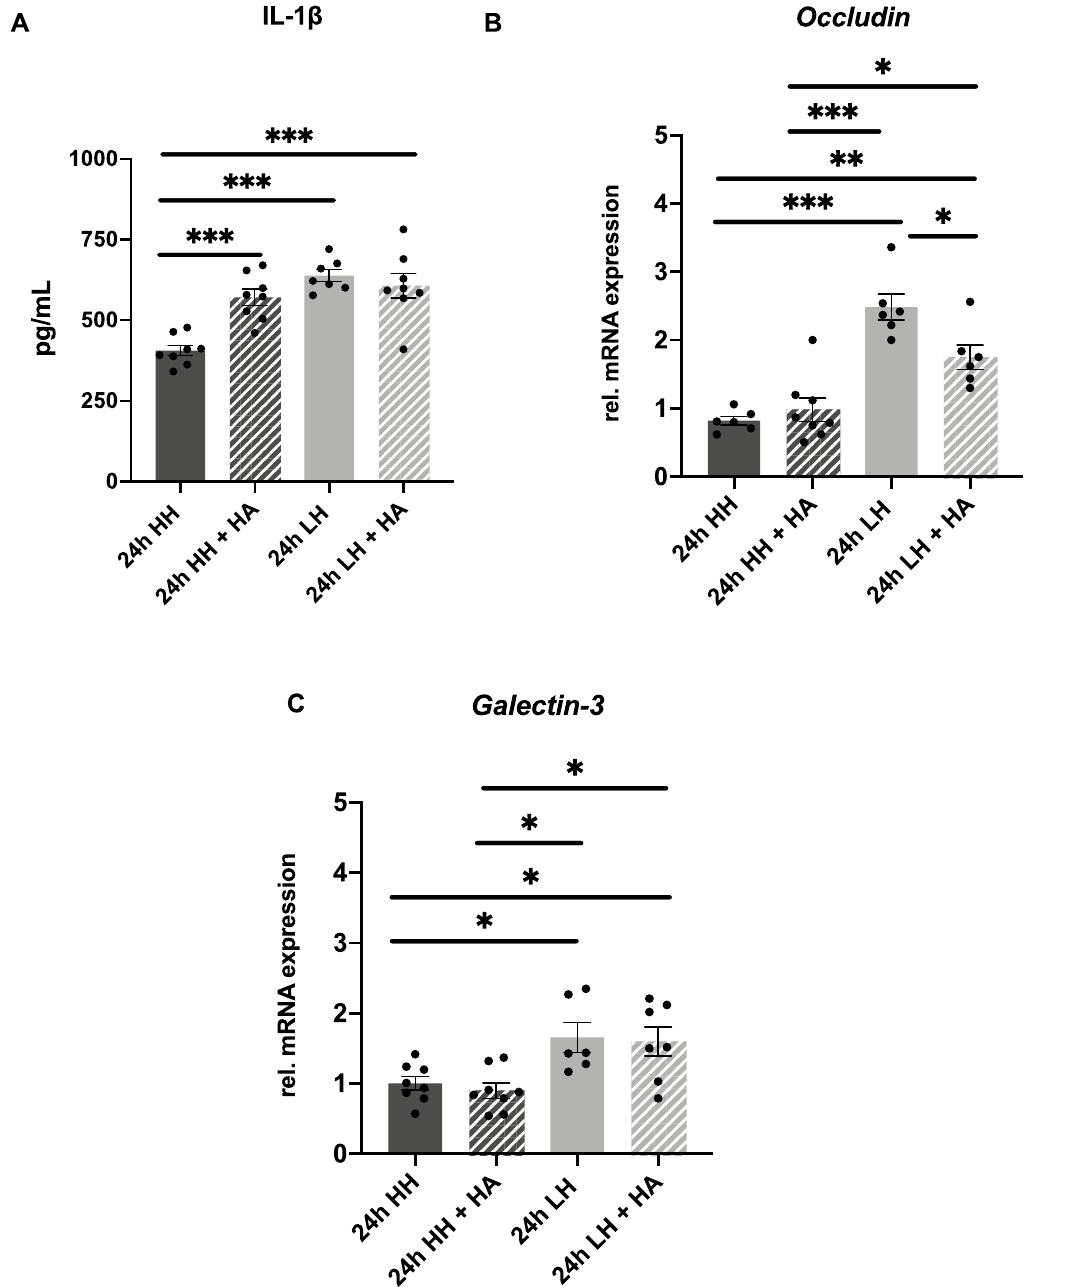
Figure 6. Hyaluronic acid (HA) partially counteracts the effects caused by LH. ( A ) No significant difference at IL-1β secretion was shown between LH + HA group in comparison do LH group (LH + HA = 607.00 pg/mL ± 37.54/LH = 638.60 pg/mL ± 18.68; p = 0.84). An increase in IL-1β was found in samples exposed to LH (638.60 pg/mL ± 18.68), to LH + HA (607.00 pg/mL ± 37.54) and to HH + HA (571.20 pg/mL ± 25.41) in comparison to the ones incubated at HH (406.10 pg/mL ± 16.45; p < 0.001) ( n = 7 for LH/ n = 8 for LH + HA/ n = 8 for HH/ n = 8 for HH + HA). ( B ) A significant hindering of increase in occludin mRNA expression was observed at the LH + HA group (1.75 ± 0.18) in comparison to LH (2.48 ± 0.19; p = 0.03). ( C ) No significant difference in galectin-3 expression was shown at the LH + HA group (1.60 ± 0.21) in comparison to LH group (1.66 ± 0.21; p = 0.04). n = 6 for LH/ n = 6–7 for LH + HA/ n = 6–8 for HH/ n = 8 for HH + HA. LH: low humidity. HH: high humidity. HA: hyaluronic acid. The bars represent the mean values, and the SEM is shown. * p < 0.05 ** p < 0.01 *** p <